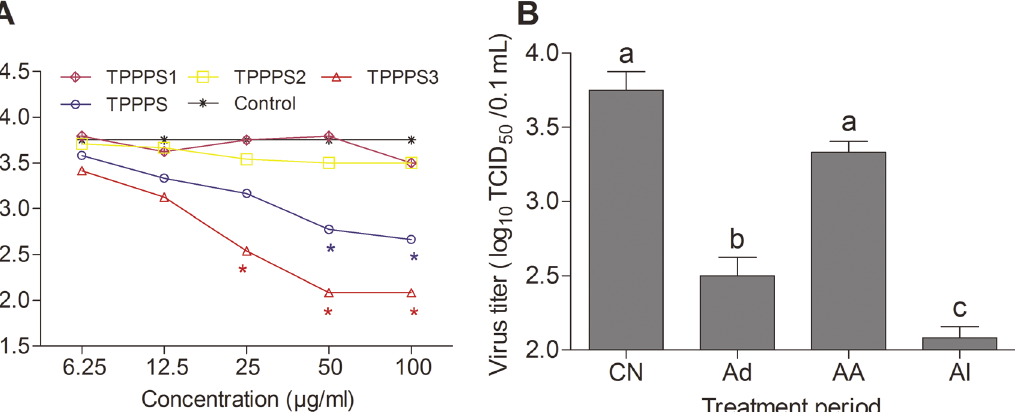
Fig 6. Effects of TPPPS1-3 and TPPPS on antiviral activity in vitro . (A) DF1 cells cultured in 24-well plates were infected with 10 μ L/well (TCID 50 of 10 3.75 / 0.1 mL) ALV-B. After 9 d of culture in MM containing different concentrations of TPPPS or TPPPS1-3, viral titers in the supernatant were directly determined by TCID 50 assays on DF1 cells. PBS treatment wells served as the control. All values shown are presented as means ± SD from three independent experiments. An asterisk indicates that the value of the corresponding group was significantly different from that of the control group ( P < 0.05, ANOVA). (B) DF1 cells infected with ALV-B were treated with 50 μ g/mL of TPPPS3 at different viral infection periods, and viral titers in the supernatant were directly determined by TCID 50 assays on DF1 cells. Ad is defined as the “ adsorption ” period; AA is defined as the period “ after adsorption ” ; Al is the period wherein the polysaccharide was always present. PBS treatment wells served as the control. All values shown are presented as means ± SD from three independent experiments. Different superscripts indicate a significant difference ( P <